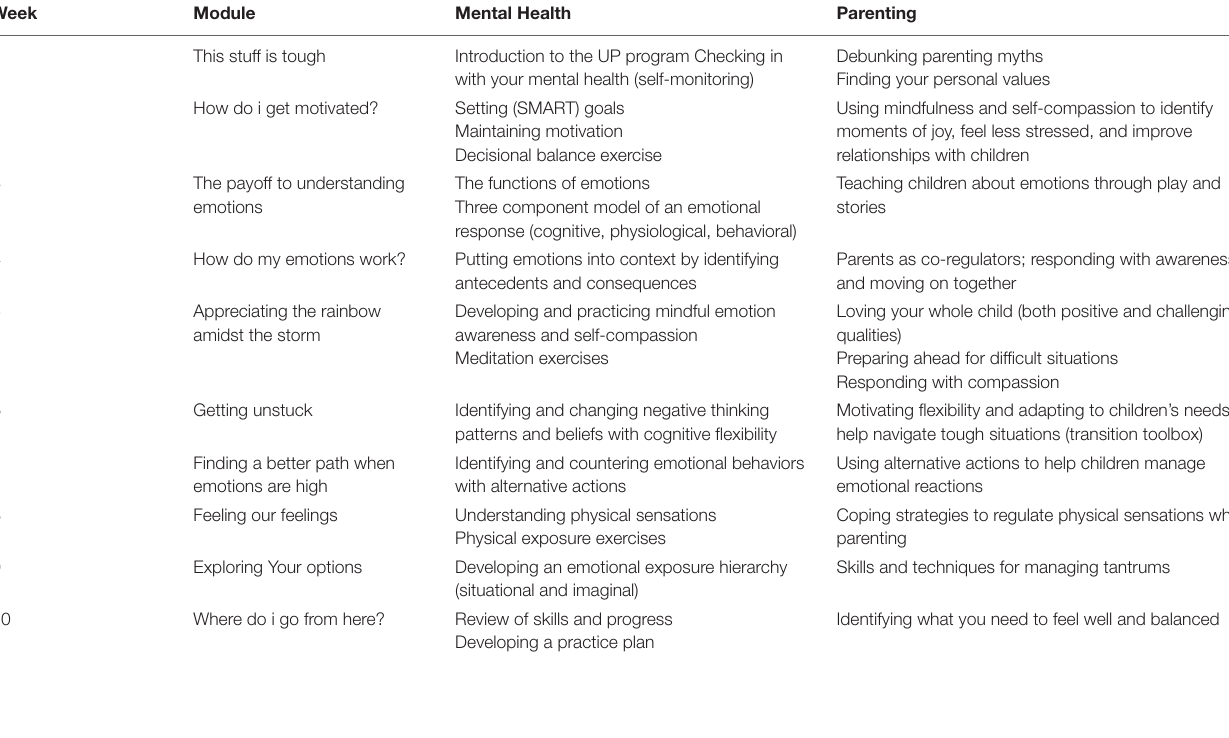
TABLE A1 | BEAM weekly module